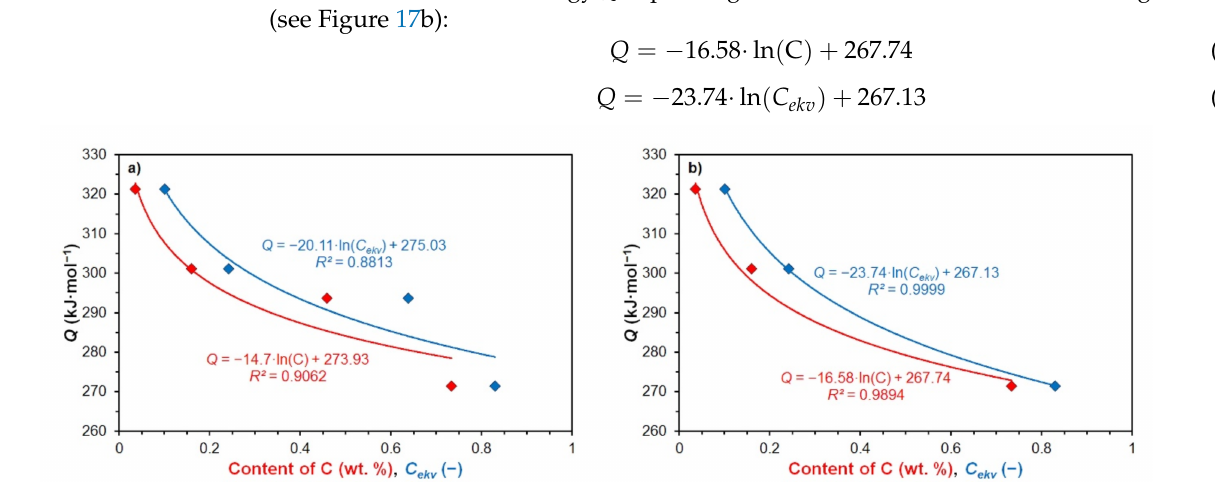
Figure 17. Dependence of hot deformation activation energy Q on carbon content and carbon equivalent of investigated steels: ( a ) for all investigated steels; ( b ) for the investigated steels A, B and D.